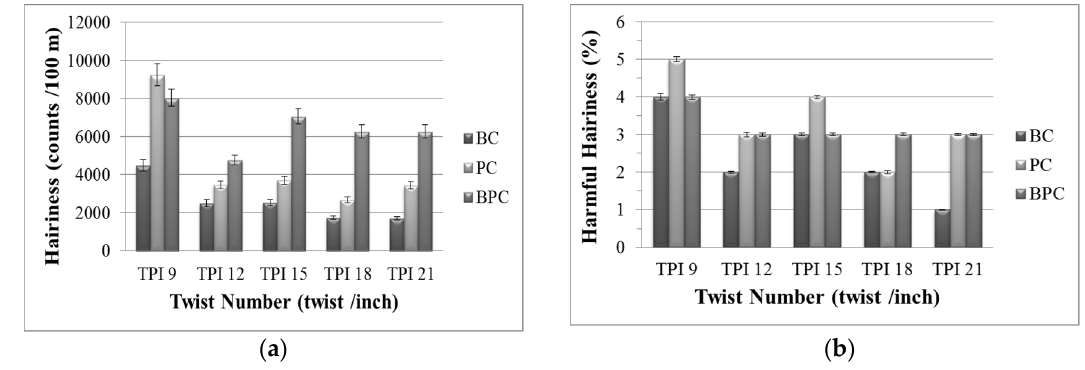
Figure 5. Total hairiness ( a ) and harmful hairiness ( b ) of BC, PC and BPC ring-spun complex yarns with different twist number (9, 12, 15, 18, and 21 TPI).